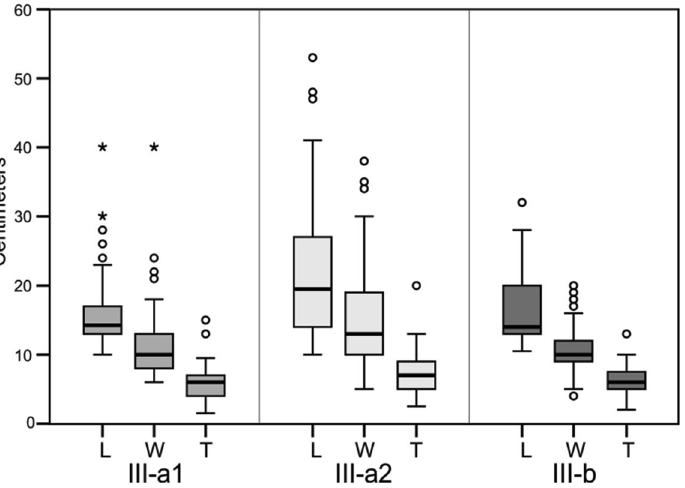
Figure 5. Boxplot of dimensions of the limestone blocks in subunits III-a1, III-a2 and III-b. L length, W width, T thickness.